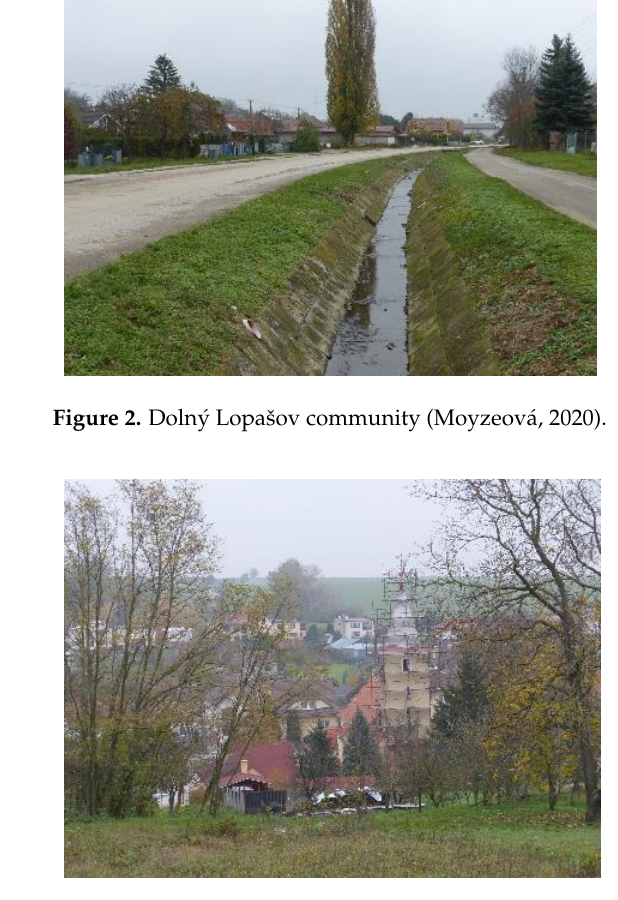
Figure 1. Dolný Lopašov community location . Technical processing: Rákayová, R. The current community cadastral territory is 2293.41 ha (Figures 2 and 3).